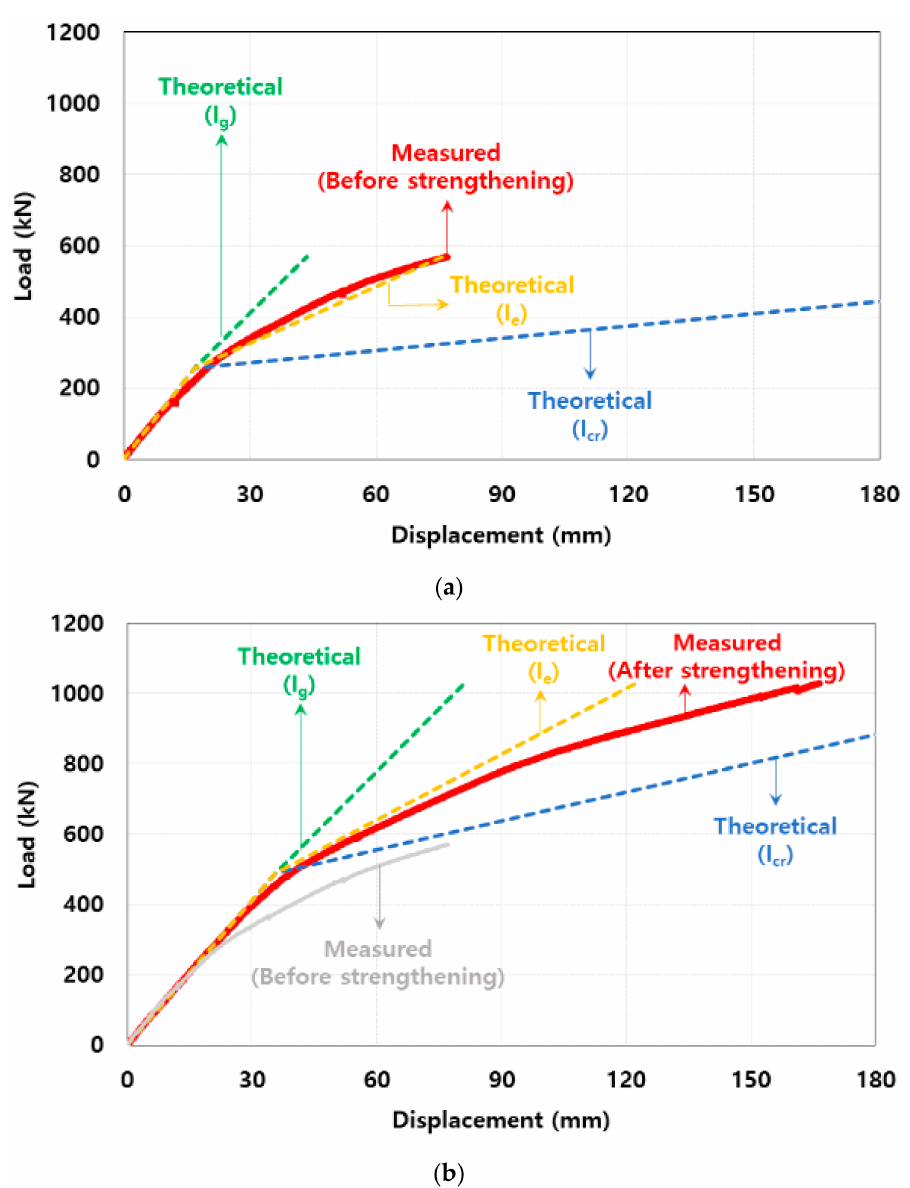
Figure 10. Load-displacement relationship: ( a ) Before strengthening; ( b ) After